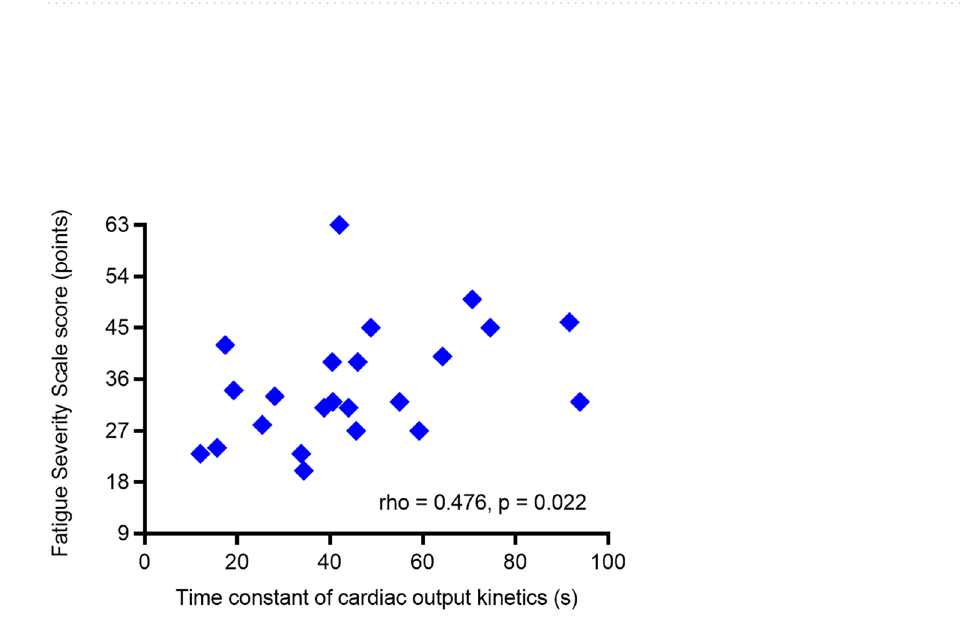
Figure 3. Correlation between the Fatigue Severity Scale score and the time constant of cardiac output